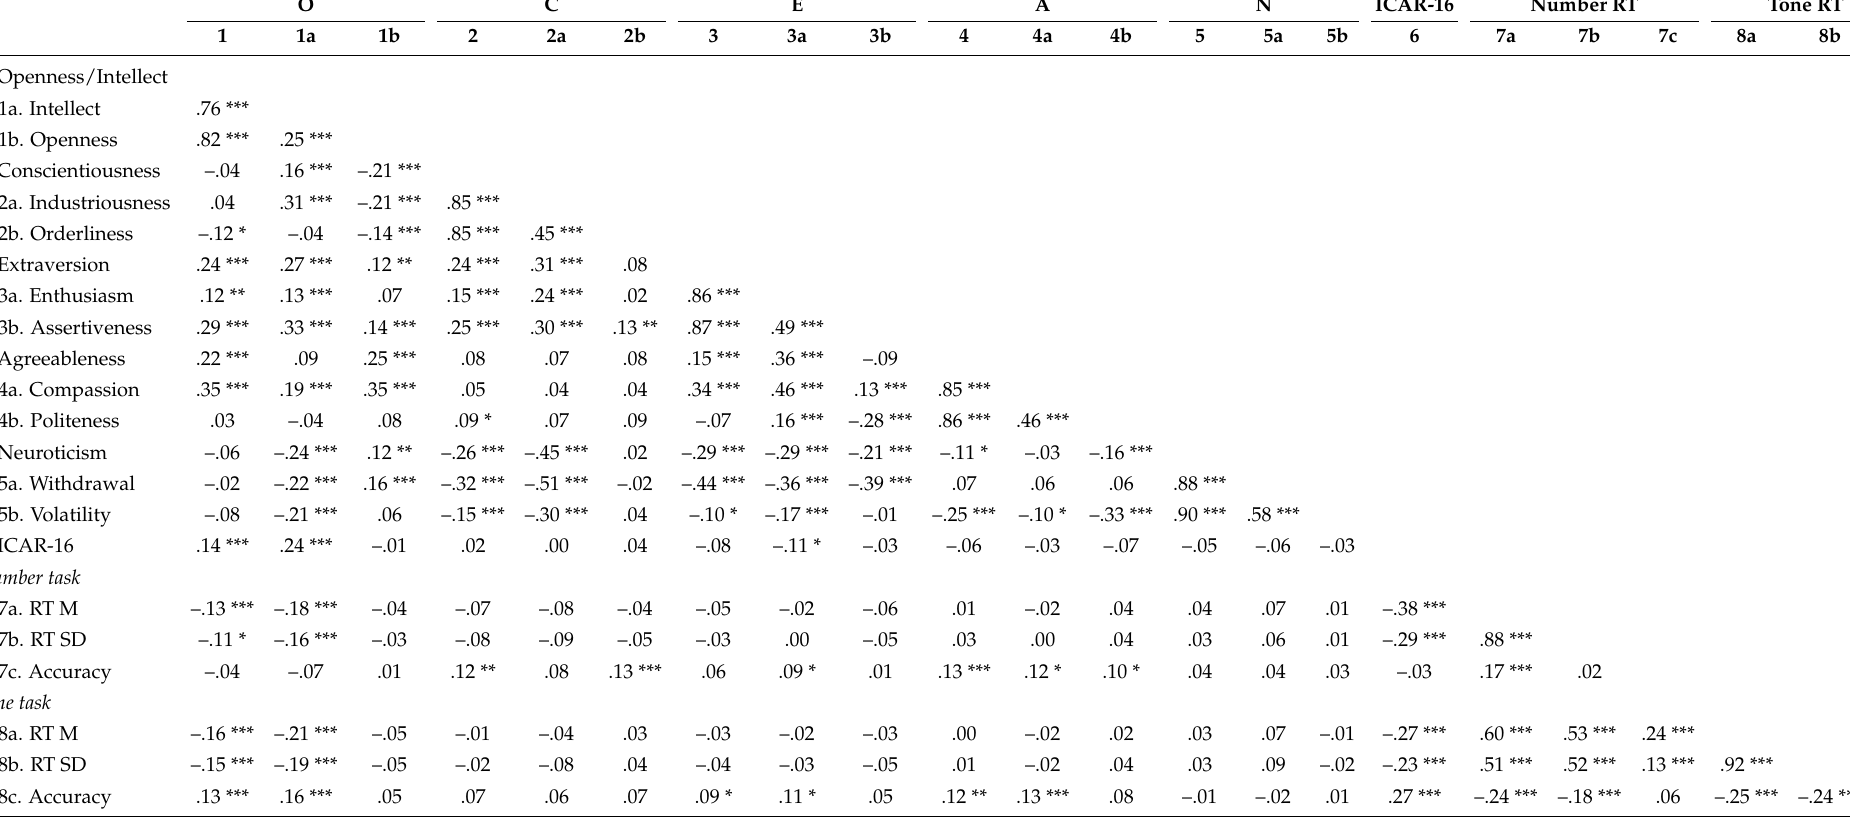
Table 5. Correlation matrix showing all interrelationships between Big Five personality factors and their respective aspects, ICAR-16 cognitive ability score, and reaction time moments (mean, SD , and accuracy) for number and tone comparison tasks.